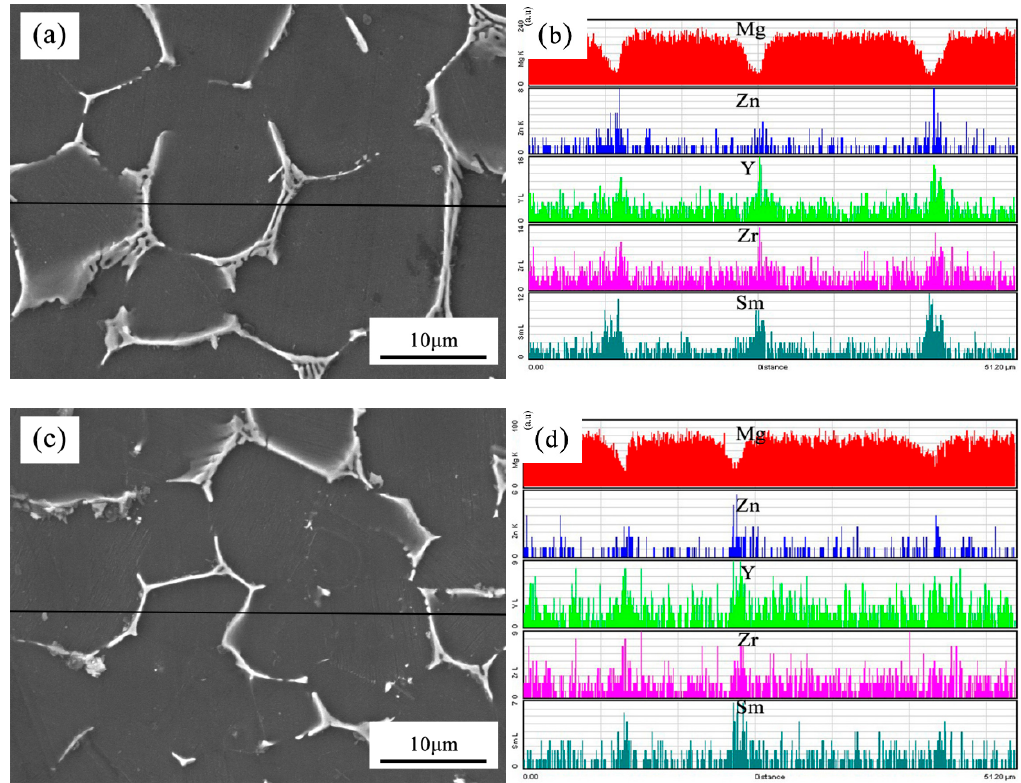
Figure 6. Line scanning images of the as-cast Mg-3Y-3.5Sm-2Zn-0.6Zr alloy: ( a , b ) Without UST; ( c , d ) with UST.